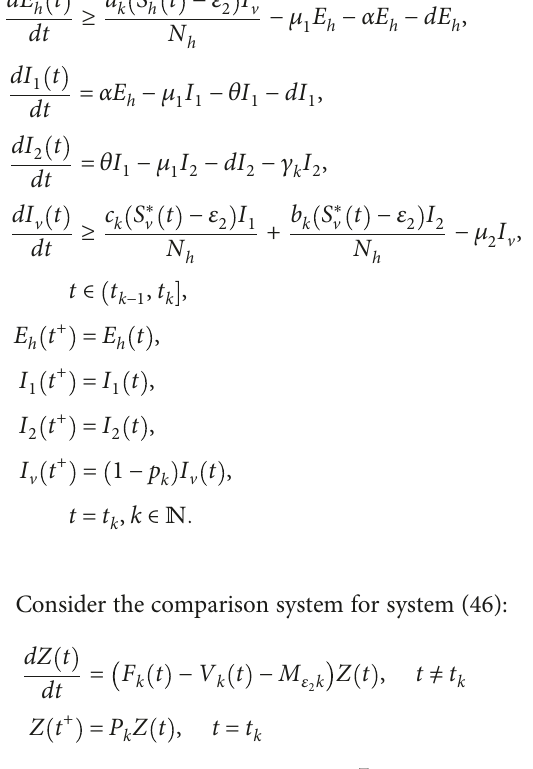
Table 1: Parameter values for system (4).